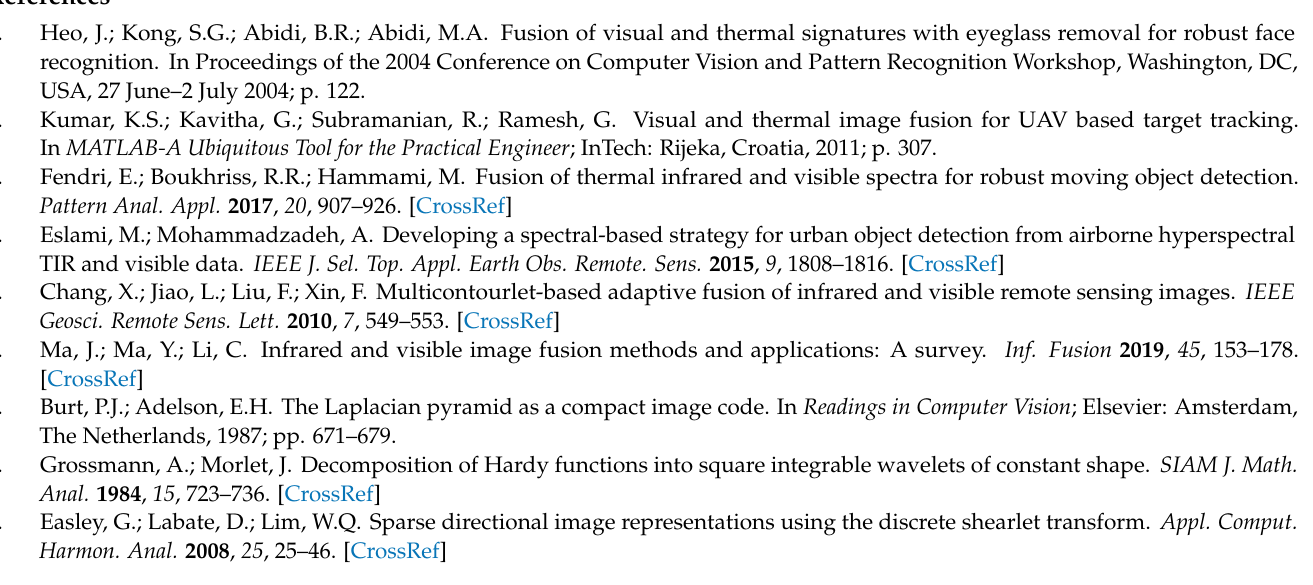
Table 2. Running Time Comparison on four experimental images. Time (s) Proposed CVT